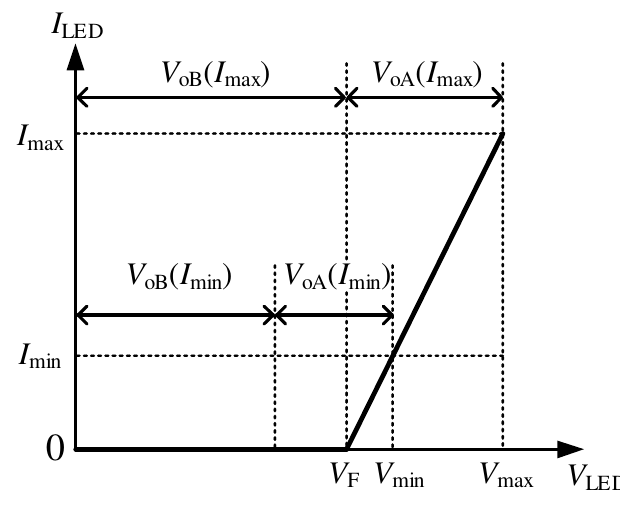
Figure 8. Output ranges of the converters with the proposed cooperative control method.